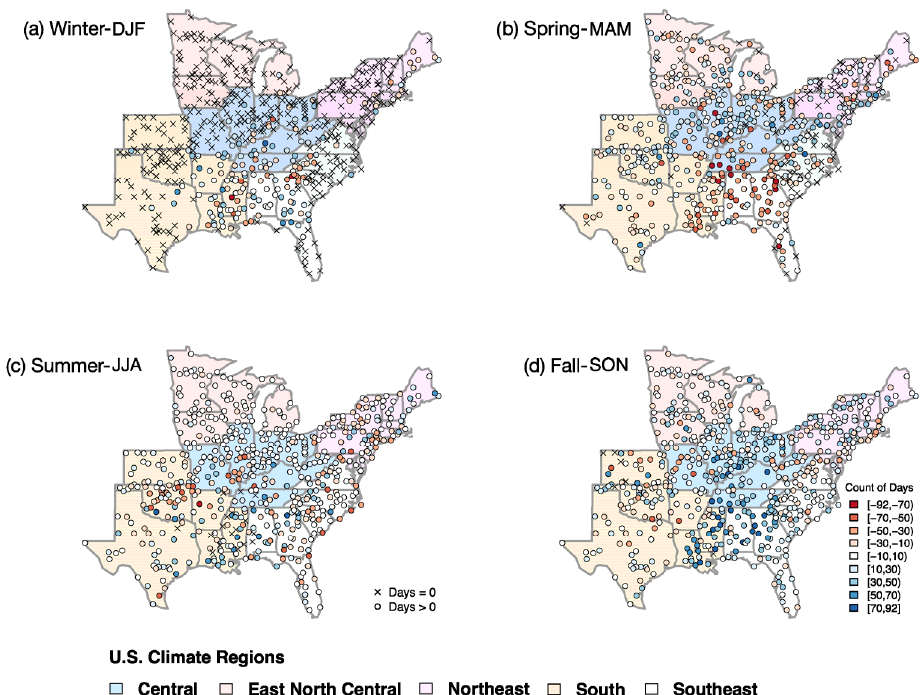
Figure 9. Temporal change in strength of seasonal modes of AMP for two 35-year blocks (1950–1984 and 1985–2019) of annual maximum daily precipitation.